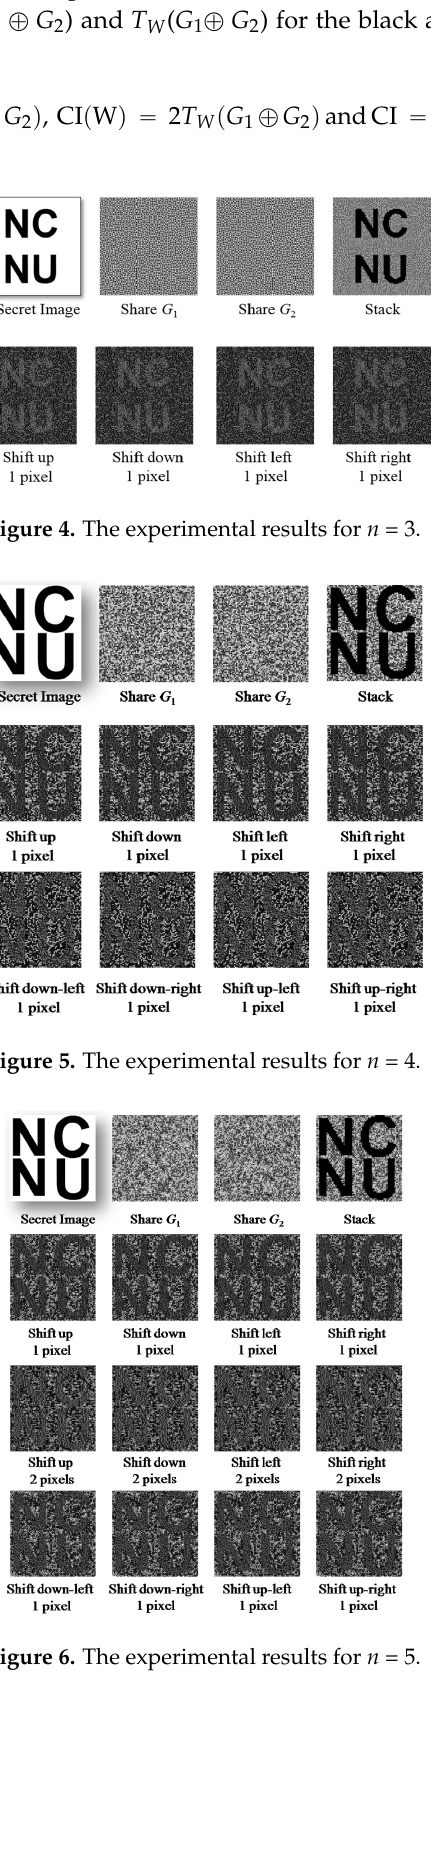
Figure 7. The experimental results for n = 6.